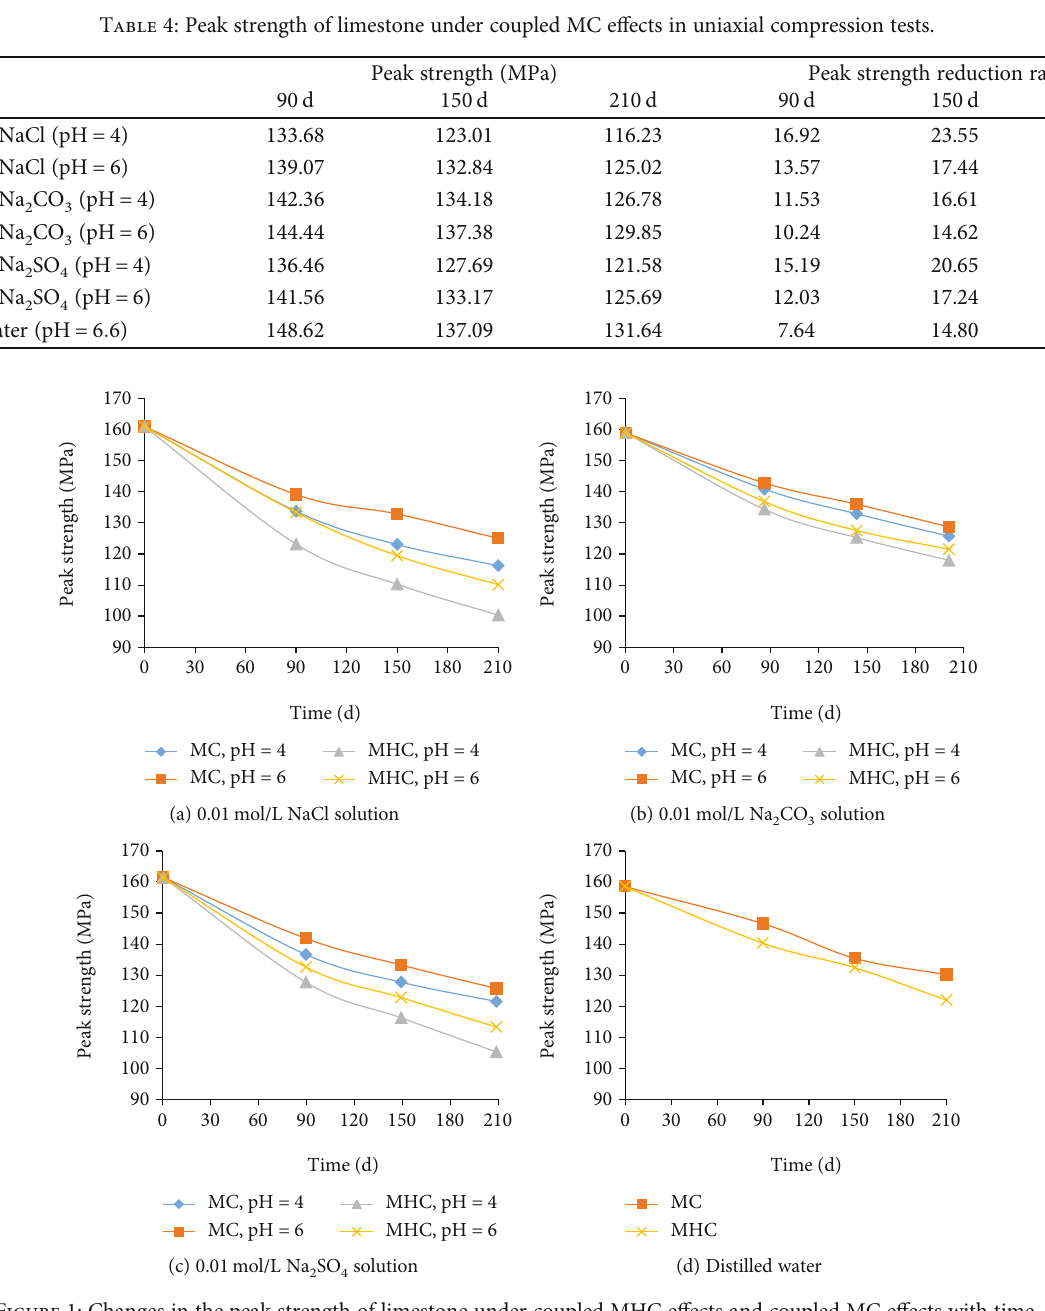
Figure 1: Changes in the peak strength of limestone under coupled MHC e ff ects and coupled MC e ff ects with